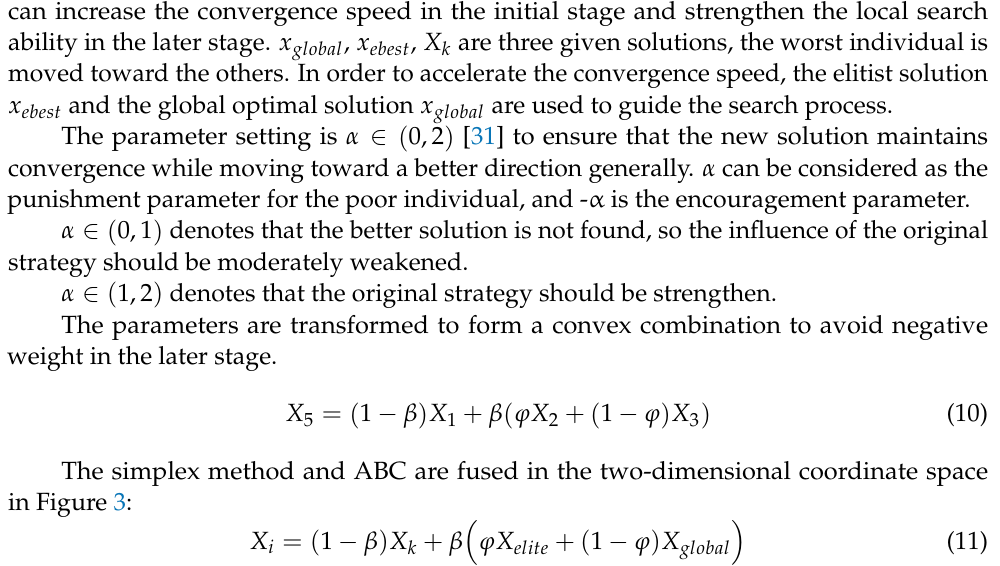
Figure 4. Disperse Operation. 3.3.2. Adaptive Adjustment In the iterative process of ABC algorithm, the neighborhood search range is con- trolled by a random parameter, and the neighborhood search is performed randomly and aimlessly. The effectiveness of the algorithm is influenced by the blindness and random- ness visibly. In order to remedy the defects, an adaptive parameter is used to adjust the algorithm’s search step length. Furthermore, in order to have stronger adaptive perfor- mance, we replace the fixed-size parameter with an alterable one, 𝑠(𝑖𝑡𝑒𝑟) , during the it- eration.